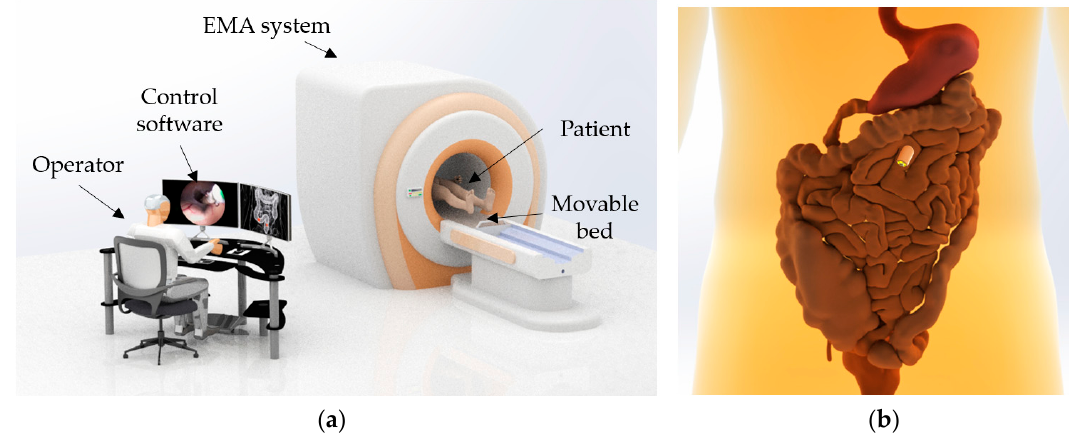
Figure 1. ( a ) Overview of the proposed biopsy capsule endoscope (CE) system. ( b ) Capsule movement in small intestine. in small